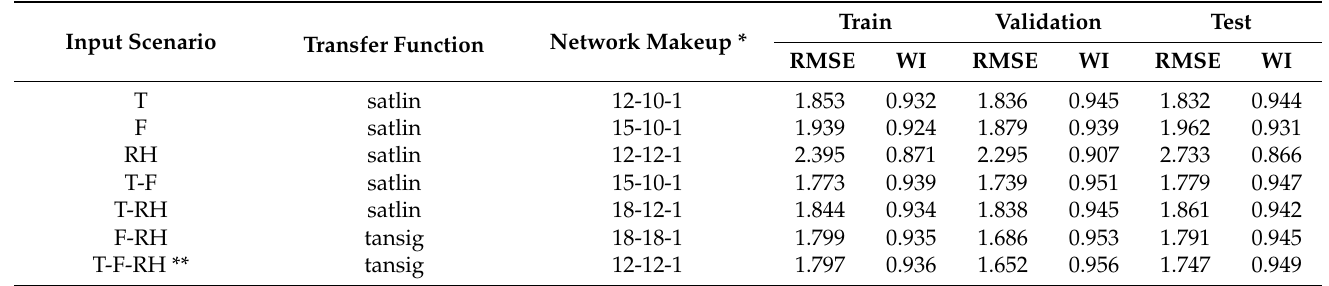
Table 3. Evaluation metrics for the pan evaporation modeling of MLP, learned by Levenberg– Marquardt algorithm